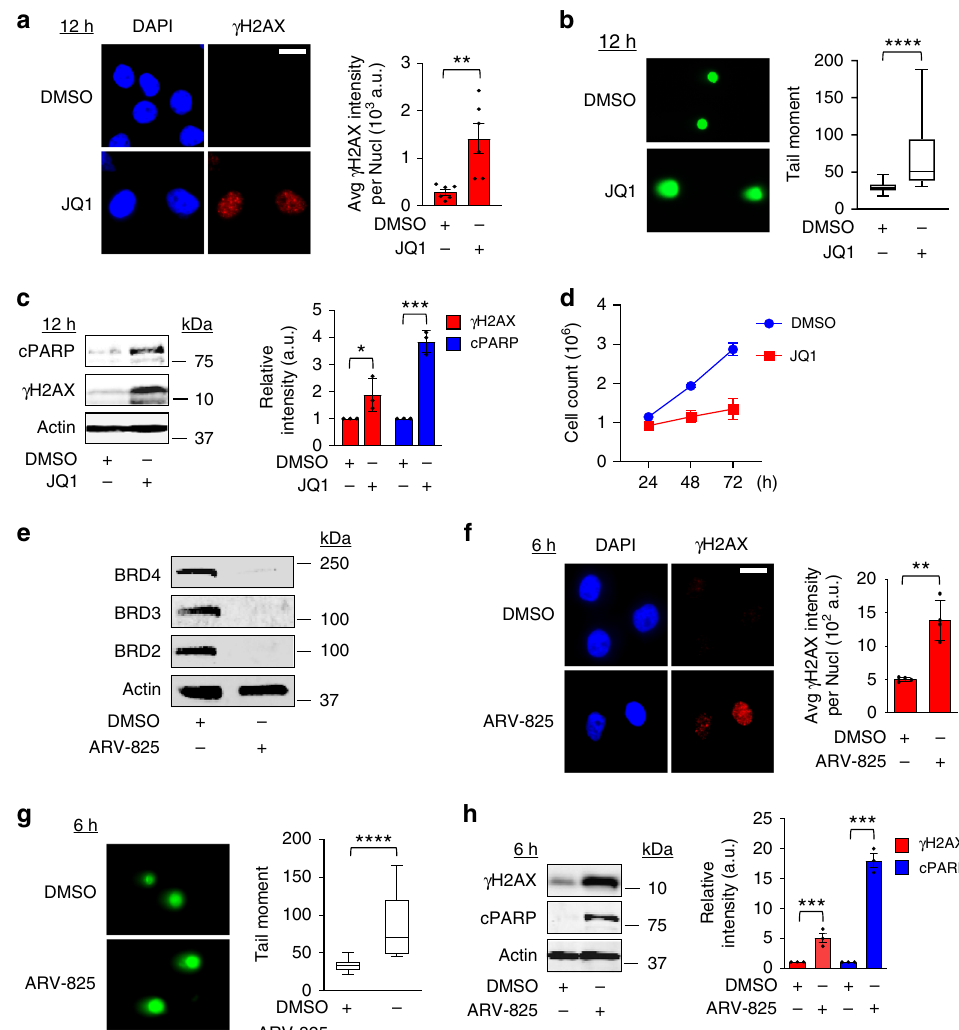
Fig. 1 BRD4 bromodomain inhibition causes DNA damage and apoptosis. a Left panel: Immuno- fl uorescence (IF) images of γ H2AX fl uorescence in